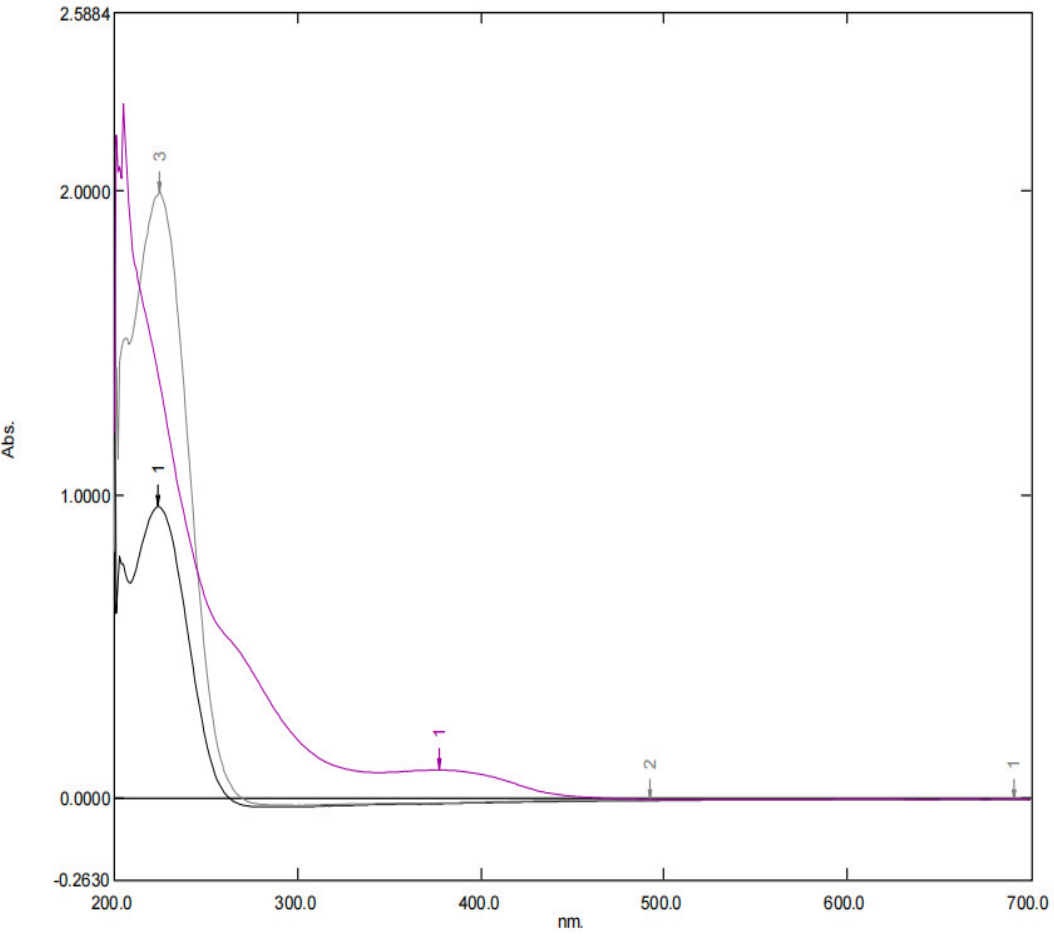
Figure 11. Chromatogram of andrographolide standard (green), isolate (blue), and andrographolide extract (red).